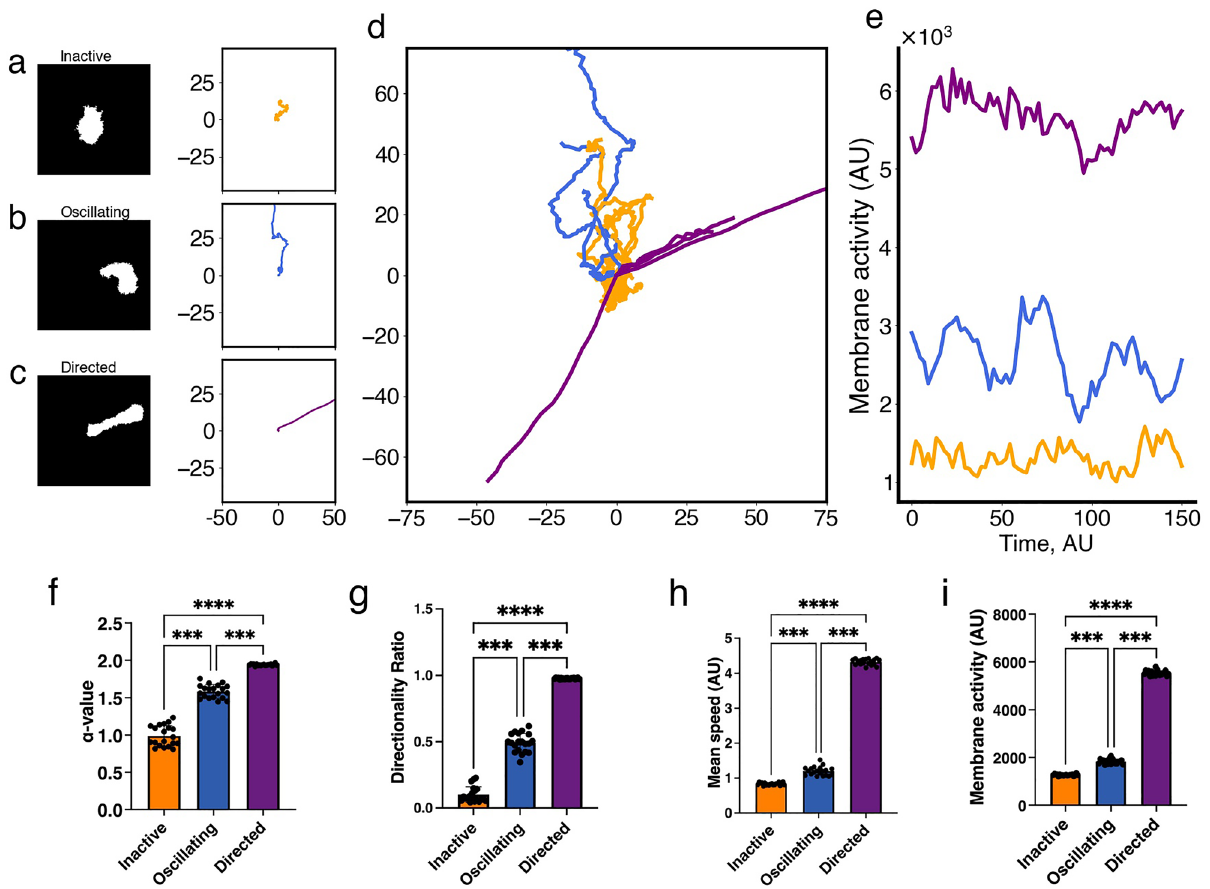
Figure 3. Characteristics of the three classes (n=20 for each group) of simulated cells obtained by the Cellular Potts Model (CPM) exhibiting distinct migration patterns detected by the two metrics: α -value, that distinguishes inactive from active CPM cells, and directionality ratio (DR), that divides active cells into oscillatory and directed cells. ( a – c ) Representative binary masks (left) illustrating the relevant shapes of CPM cells, along with their representative migration tracks (right). ( d ) Roseplots of a sample (n = 21) of CPM cell tracks colour-coded according to each class; orange: inactive, blue: oscillatory, purple: directed. ( e ) Time series of the level of membrane activity of three representative CPM cells, colour-coded according to each class. ( f ) Mean α -value of CPM cells in each class. ( g ) Directionality ratio (DR) for the entire trajectory of CPM cells in each class. ( h ) Mean instantaneous speed of CPM cells in each class. Inactive cells have a non-zero mean instantaneous speed due to their inherent stochasticity, causing them to be random. ( i ) Mean level of membrane activity, in terms of pixel counts, CPM cells in each class. Error bars indicate SEM. Black dots represent individual of this latter group is governed by MMOs (and hence labelled “oscillating” CPM cells hereafter), while directed cells are purely governed by wave-pinning 25,26 . All the simulated CPM cells appeared to fall into one of these three classes of migration patterns (Fig. 3d) and their levels of membrane activity seemed to positively correlate with their ability to migrate (Fig. 3e). Interestingly, CPM cells in the oscillating class were found to also exhibit slow oscillations in their membrane activity, unlike the other two classes (Fig. 3e). Oscillating CPM cells on average show membrane activity that is 1.945 times higher than inactive CPM cells, a ratio that is similar to the 1.825 obtained for active versus inactive CHO-K1 cells. To systematically categorize the classes of CPM cells, we applied the same strategy used on CHO-K1 cells by using the 1.4-threshold in α -value to separate inactive CPM cells from active ones. The active CPM cells were